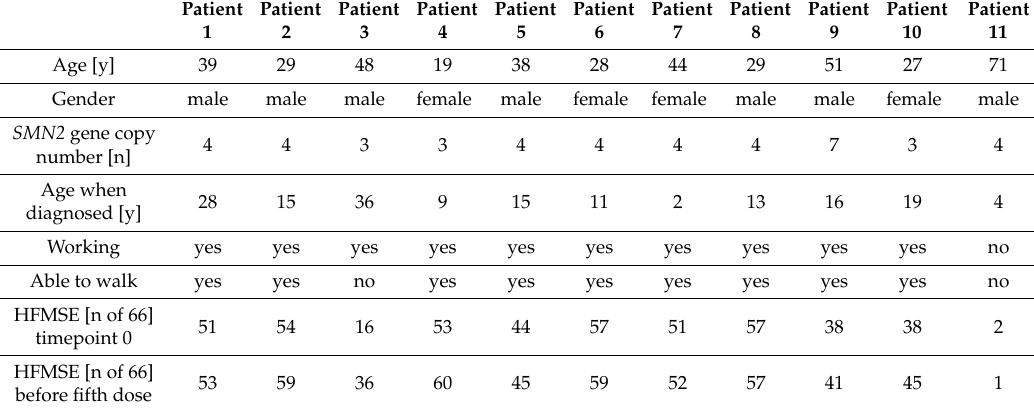
Table 1. Clinical data on Patients 1–11, including test values of Hammersmith Functional Motor Scale Expanded